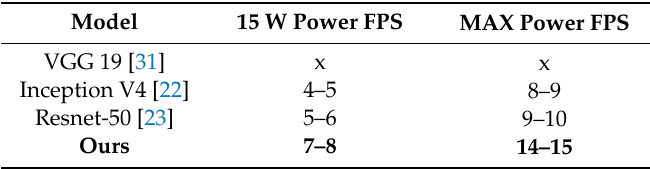
Figure 8. Confusion matrix of RGB camera-17. Table 2. Frames per second between models and module power modes.